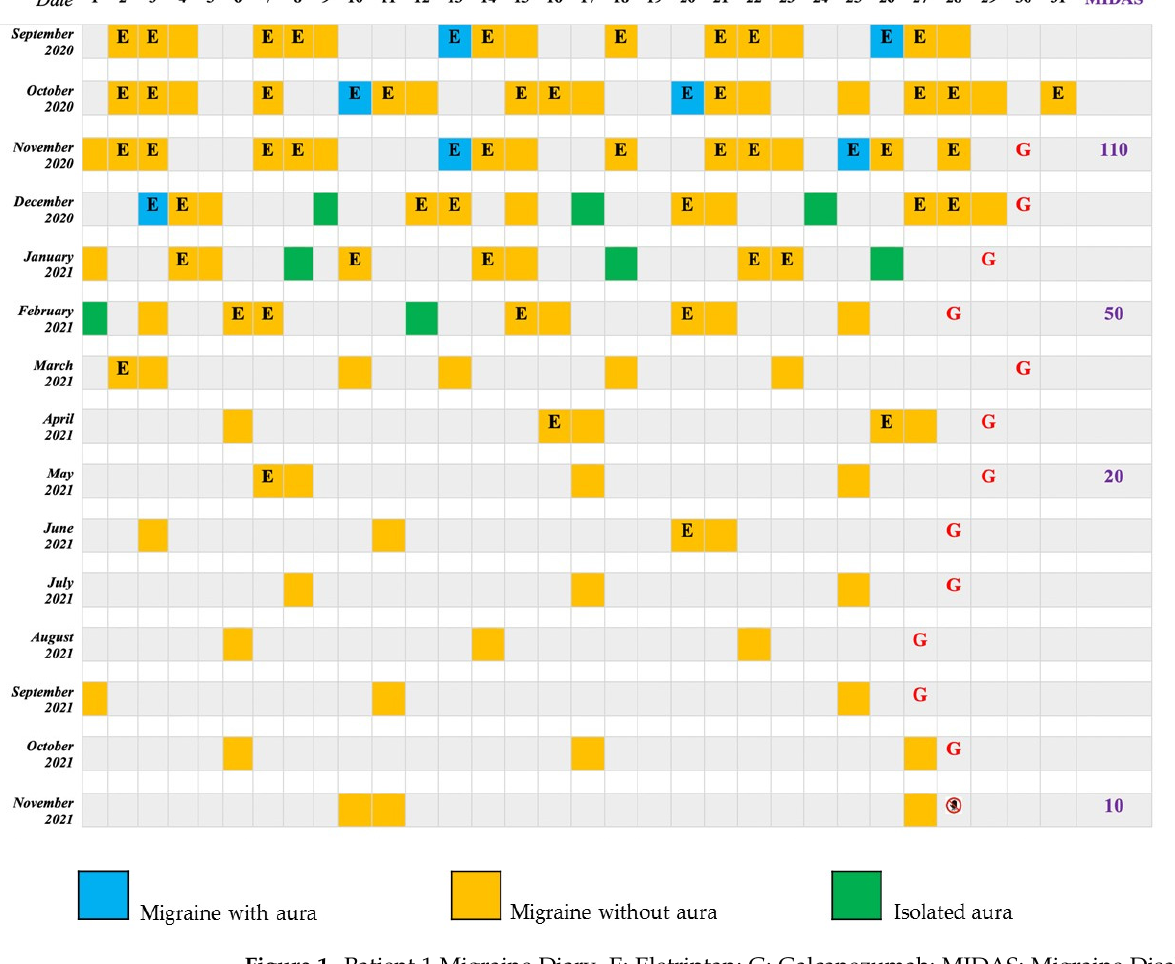
Figure 1. Patient 1 Migraine Diary. E: Eletriptan; G: Galcanezumab; MIDAS: Migraine Disability Assessment Test Score; 1 month after Galcanezumab discontinuation.